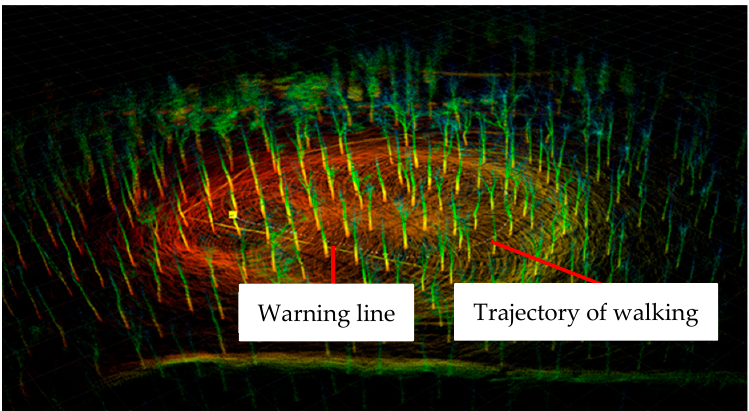
Figure 3. 3D point cloud map of the forest area.